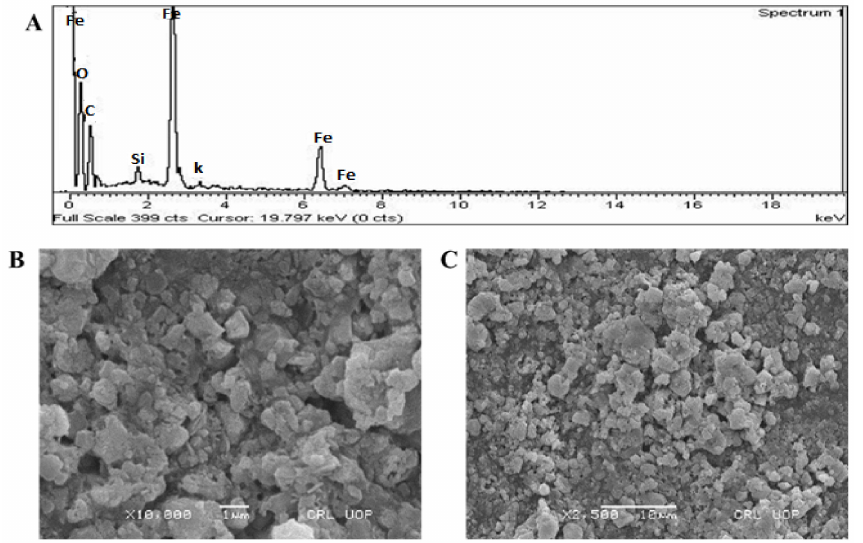
Figure 4. ( A ) Typical EDX spectrum; ( B ) SEM micrographs at 1 µ m; and ( C ) SEM micrographs at 10 µ